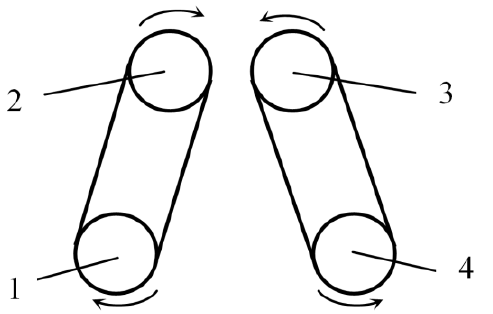
Figure 8. Rotational direction of motors and snapping rollers. 1. Sprocket of right motor. 2. Right snapping roller. 3. Left snapping roller. 4. Sprocket of the left motor.